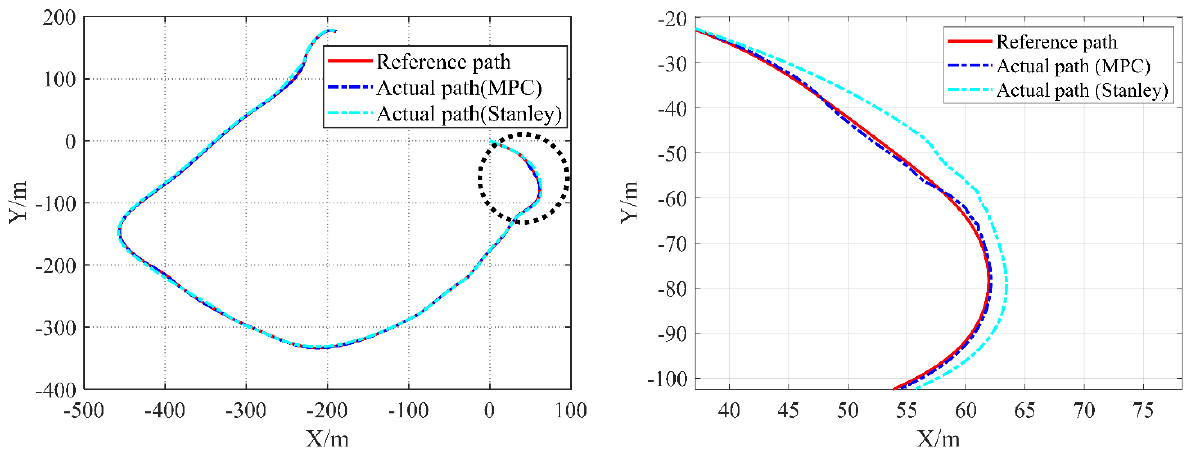
Figure 6. Global trajectory of MPC control and Stanley control ( left ). Large curvature route ( right ).